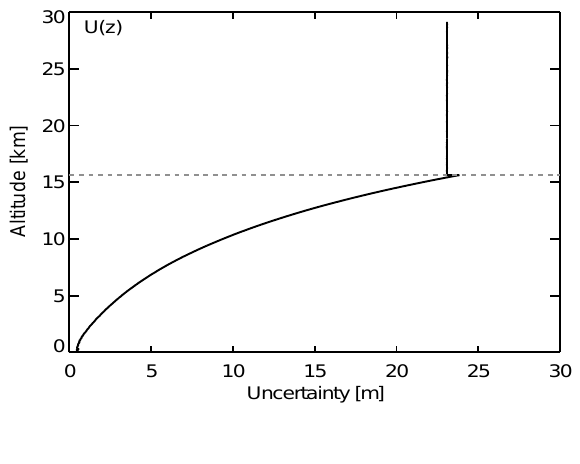
Fig. 20. Uncertainty profile of the geometric altitude, U ( z ) . Between the surface and the switch altitude, indicated by the dashed grey line, U ( z ) equals the uncertainty of the geometric pressure altitude, above that U ( z ) equals the uncertainty of the GPS altitude. Same sounding as in Fig. 19. Figure 20. Uncertainty profile of the geometric altitude, U(z) . Be- tween the surface and the switch altitude, indicated by the dashed grey line, U(z) equals the uncertainty of the geometric pressure al- titude; above that U(z) equals the uncertainty of the GPS altitude. Same sounding as in Fig. 19.